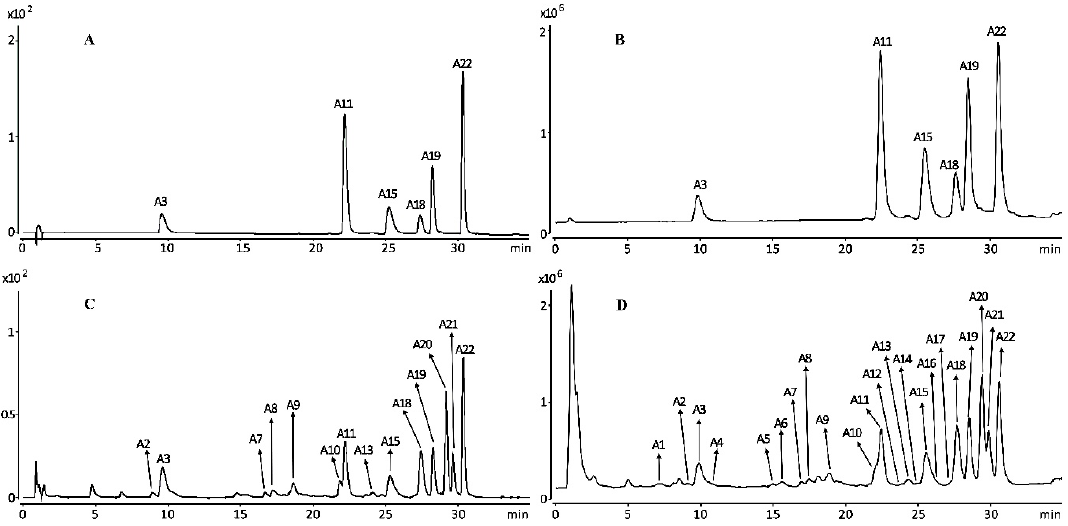
Figure 1. Chromatograms ( A, C ) and total ion chromatograms ( B, D ) of standards and samples of Iris lactea (A, B: Standard; C, D: Sample). A3 : mangiferin, A11 : embinin , A15 : irislactin C, A18 : embinin A, A19 : irislactin A and A22 : embinin C.